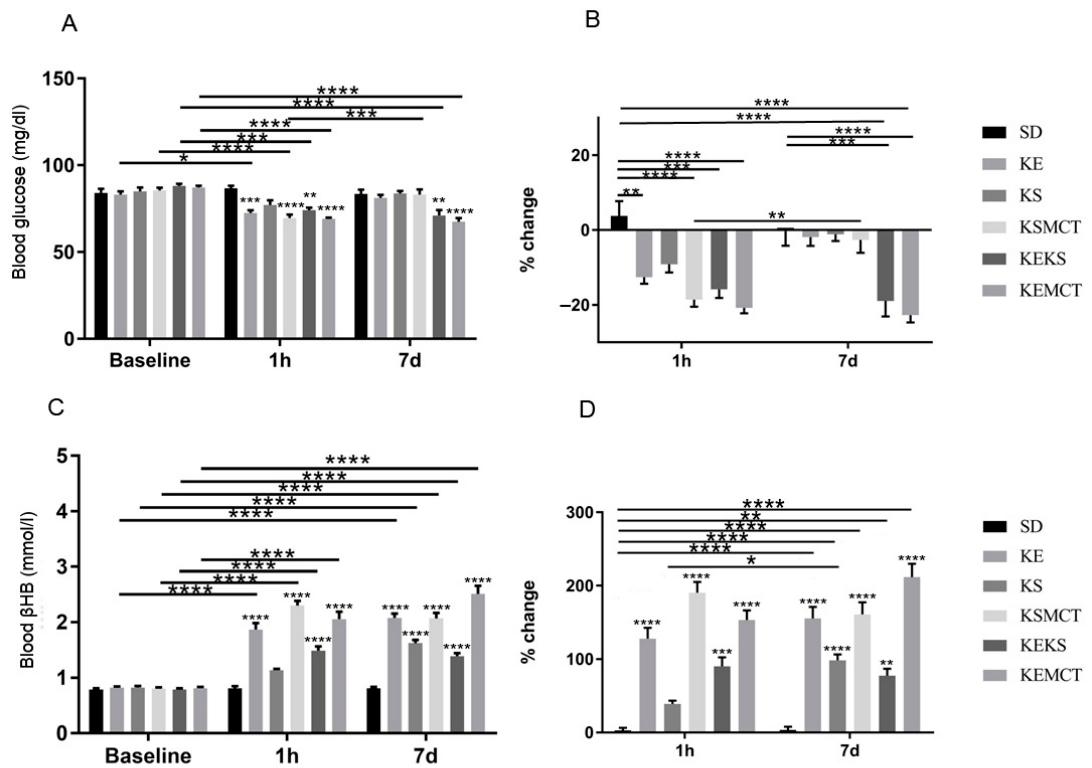
Figure 6. Changes in blood glucose and R - β HB levels of 6-month-old WR rats after 1 h and seven days of treatment, in post-exercise state. ( A ) The change in glucose levels in WR rats, with exercise, for the baseline, 1 h and seven days of the treatment. ( B ) The corresponding percent change in glucose levels. ( C ) The resulting blood R - β HB levels. ( D ) The percent change in the blood R - β HB